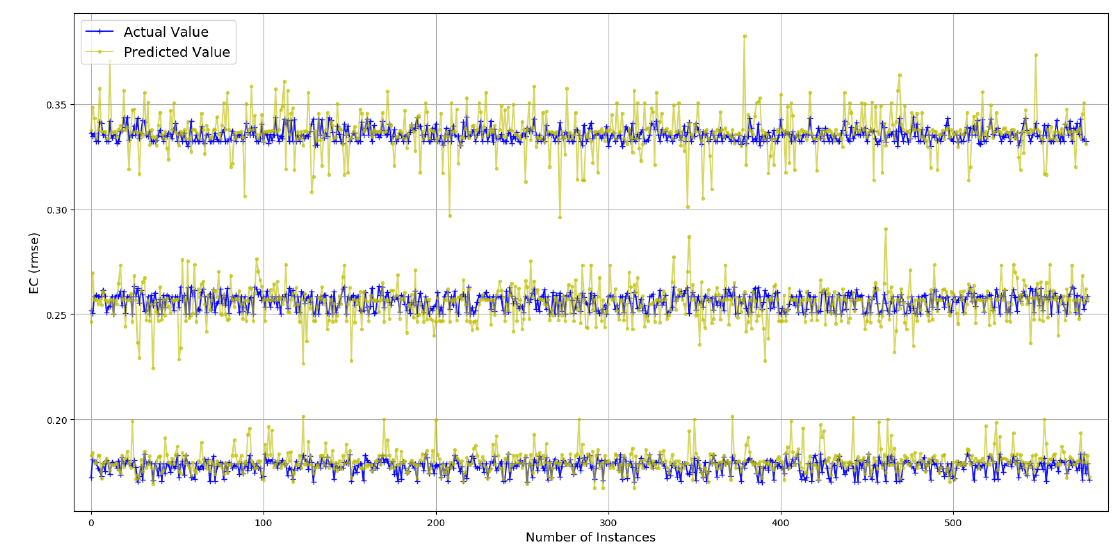
Figure 8. Actual values vs. predictions for EC dense (selected